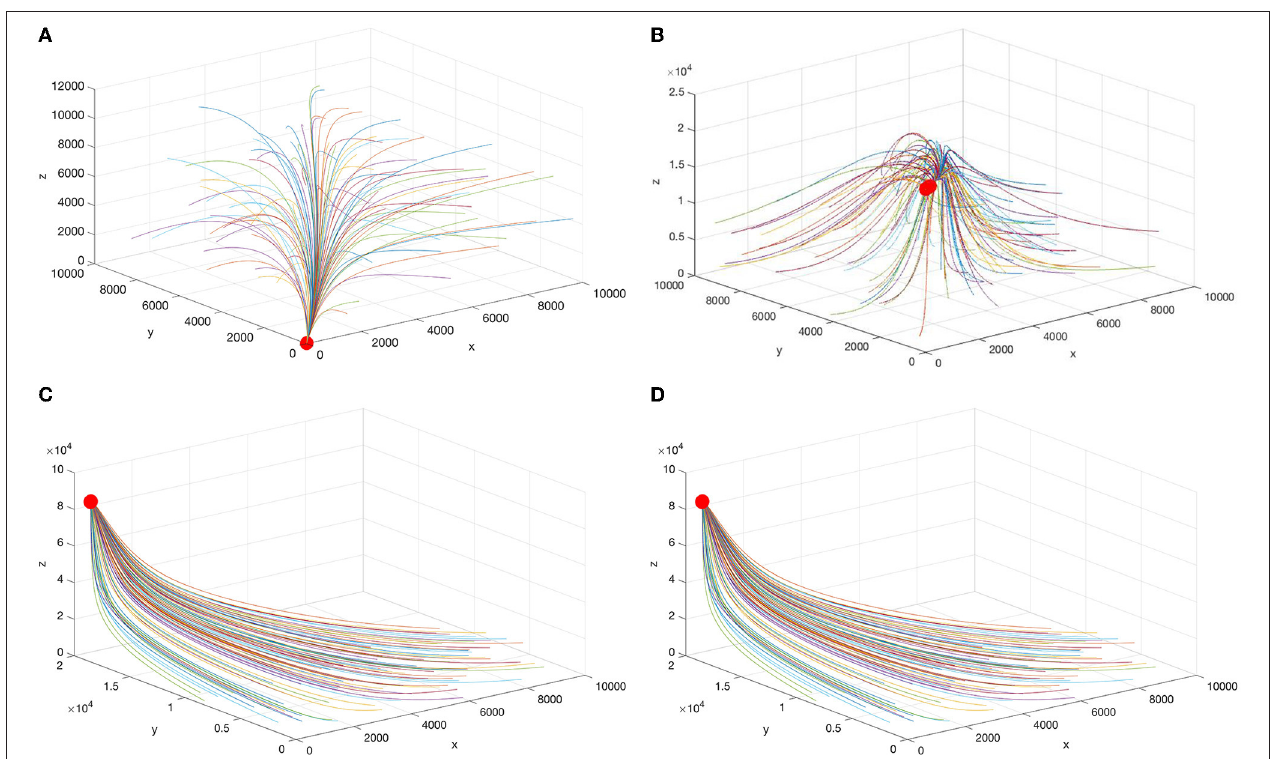
FIGURE 1 | Schematic diagram of the equilibrium points under different parameters. (A) E * 1 , (B) E * 2 , (C) E * 3 , and (D) E * 4 .